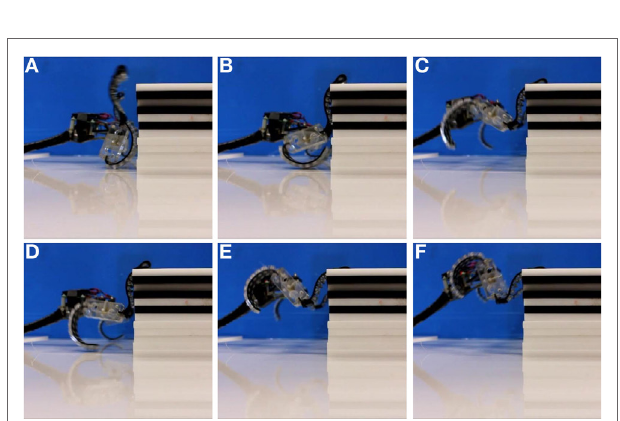
FigUre 6 | (a–F) Sequential images of hook leg during interaction with stair and climbing.